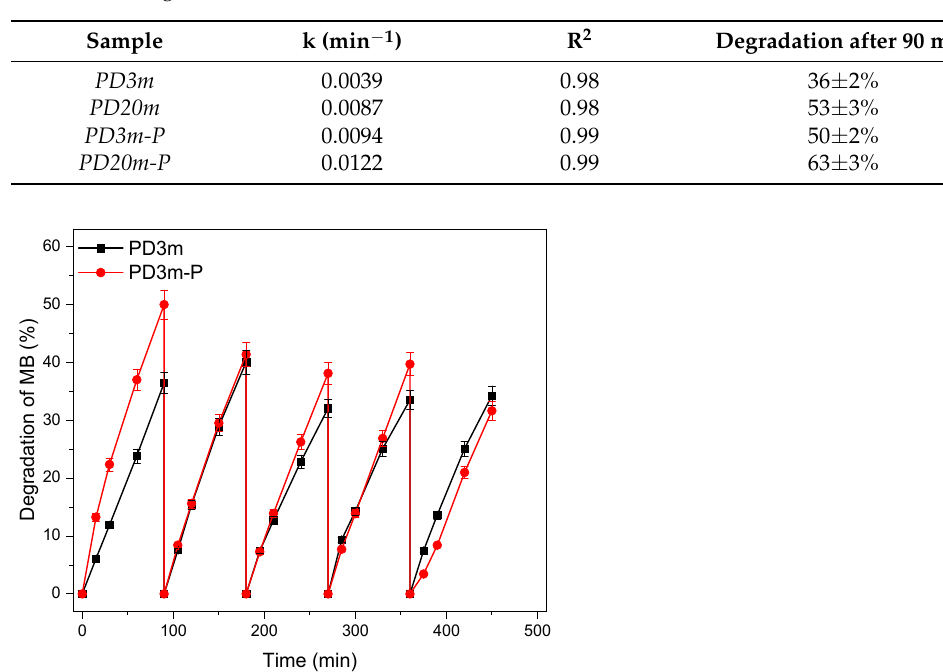
Figure 6. MB degradation assisted by the PD3m , PD3m-P , PD20m , and PD20m-P coatings. The experiments were carried out under UV light irradiation. The MB concentration was evaluated by monitoring the absorbance intensity at 665 nm. The experimental data are reported as the mean values of three replicates ± standard deviations. Table 5. The kinetic constants, R 2 , and degradation achieved after 90 min of UV irradiation of the different coatings.